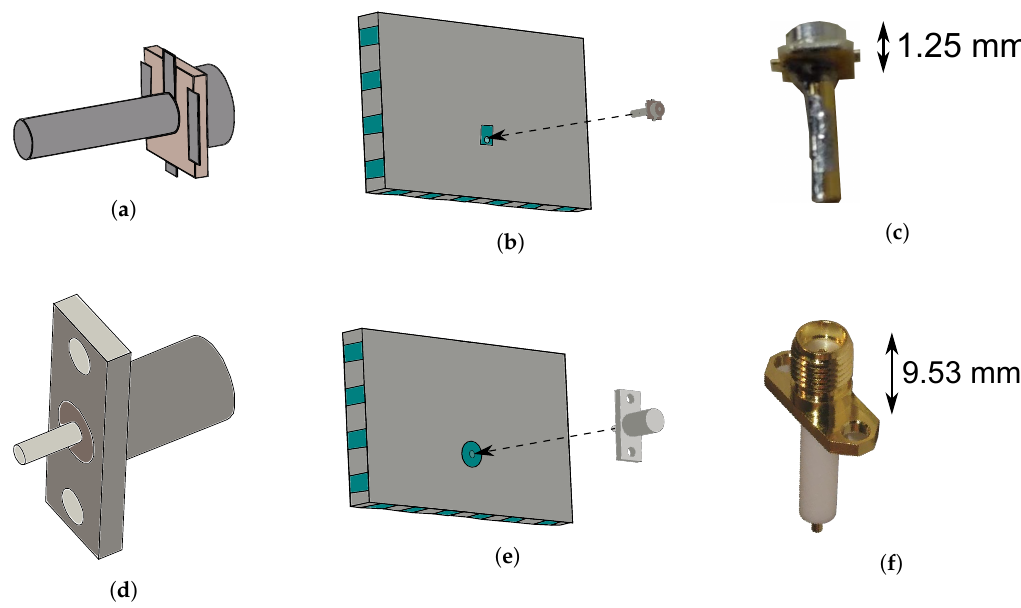
Figure 5. Final step of the fabrication process: Connector placement. ( a ) Model of U.FL connector with mounted pin, bottom side; ( b ) Already perforated cavity, insertion of U.FL connector with mounted pin into cavity; ( c ) U.FL connector with soldered pin; ( d ) Model of SMA connector with trimmed pin, bottom side; ( e ) Already perforated cavity, insertion of SMA connector with mounted pin into cavity; ( f ) SMA connector.